Question: In one sentence, what is this figure communicating?
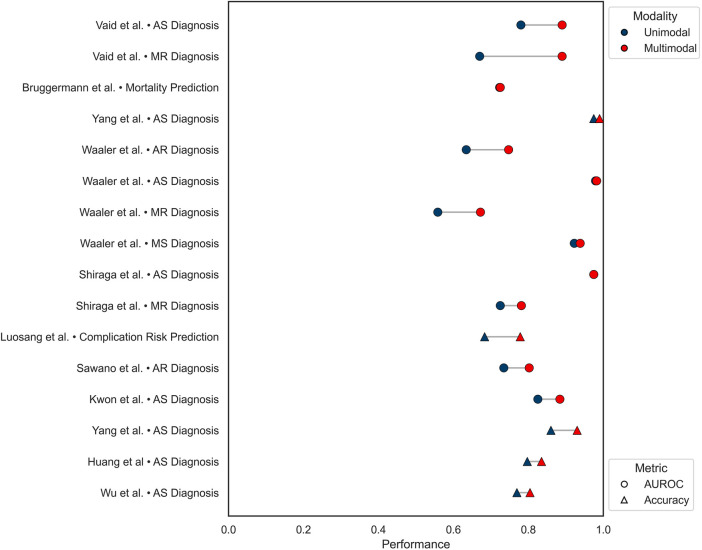
Answer: Comparative performance of multimodal and unimodal models in representative studies. AR, aortic regurgitation; AS, aortic stenosis; MR, mitral regurgitation; MS, mitral stenosis.